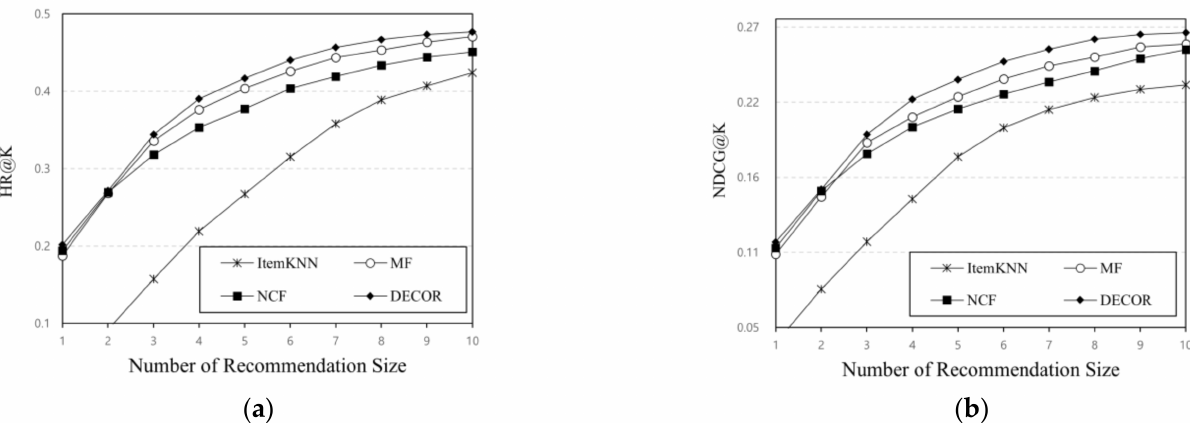
Figure 4. This figure shows the impact of recommendation size on performance: ( a ) Evaluation of HR, where K ranges from 1 to 10; ( b ) Evaluation of NDCG , where K ranges from 1 to